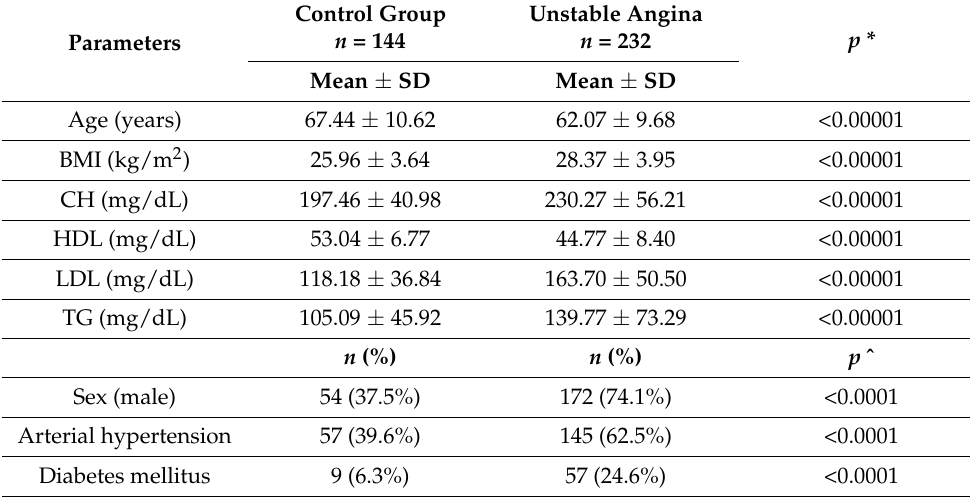
Table 1. Clinical characteristics of patients and control